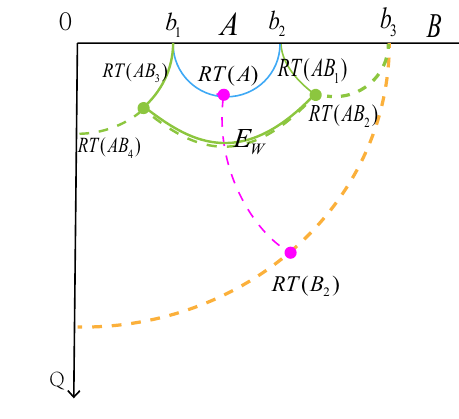
Figure 23 . Left: two right-angled pentagons and thus the lower bound c four right-angled pentagons and thus the lower bound 2 c